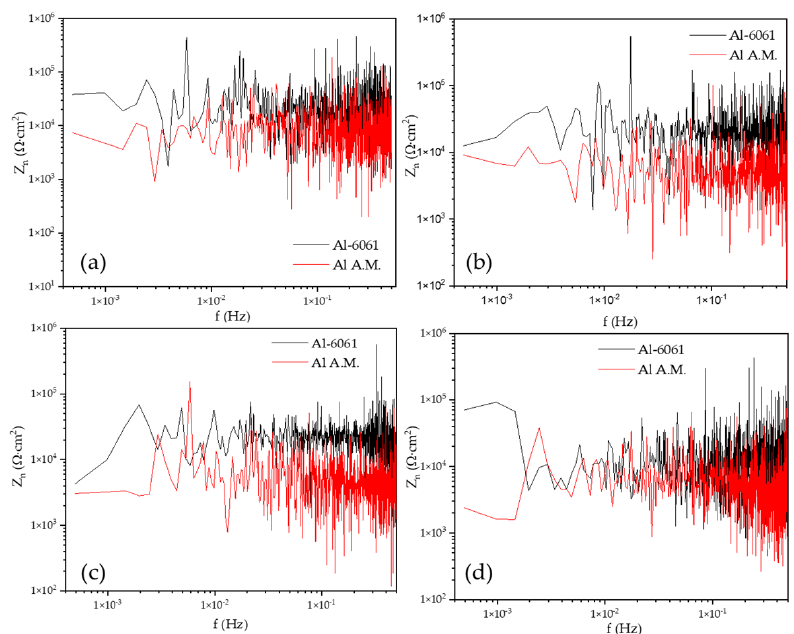
Figure 10. Noise impedance in H 2 O solution, ( a ) 0 h, ( b ) 24 h, ( c ) 48 h, and ( d ) 120 h.